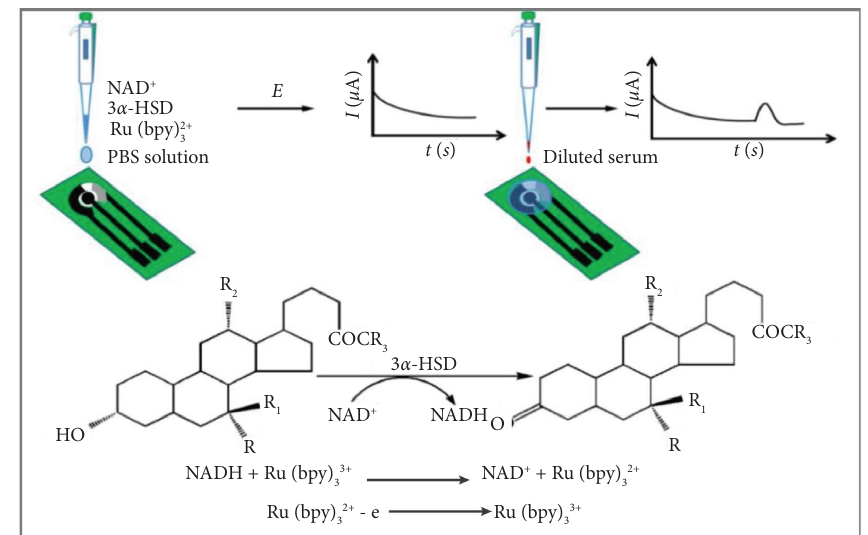
Figure 5: Principle of enzymatic coupling double oxidization electrochemical detection of bile acids (reprinted from